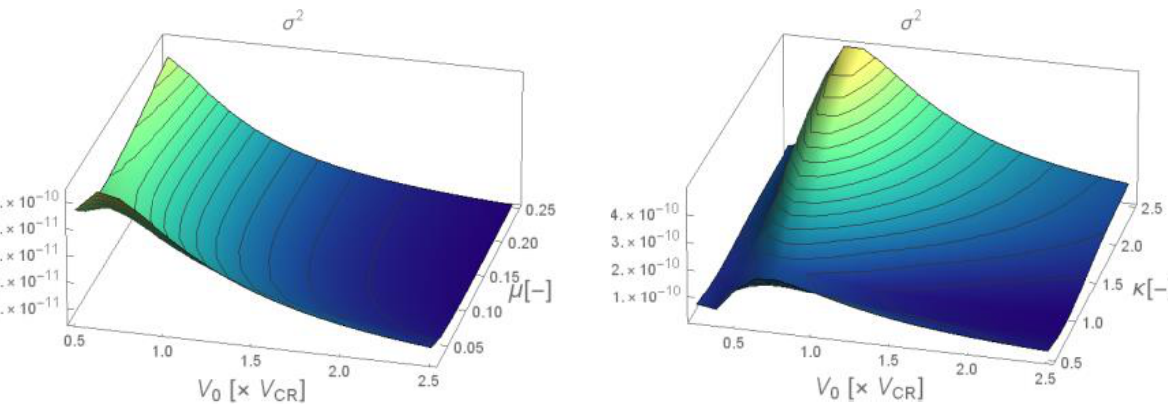
Figure 9: The variance of deflections in the midspan for different vehicle velocities, and also for (a) different parameters μ of the absorbers and (b) different parameters κ of the absorbers.